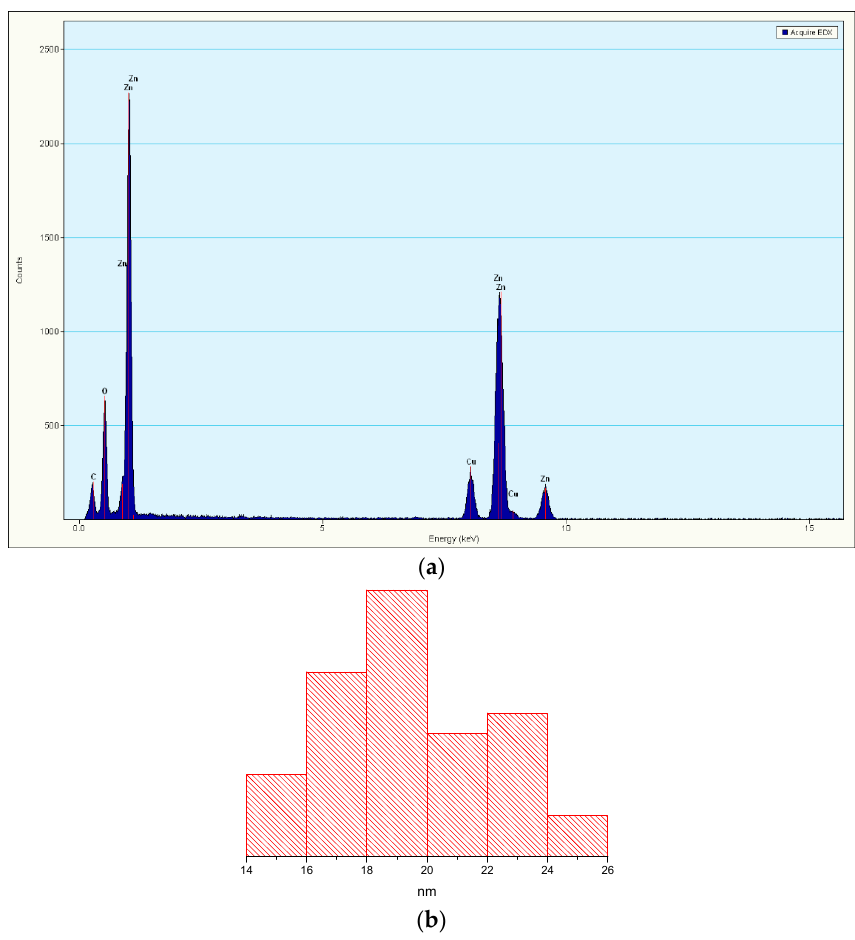
Figure 2. ( a ) EDX spectrum with Zn L α and K α lines (Cu lines are due to the copper grid used for placing the sample); ( b ) particle size distribution histogram.